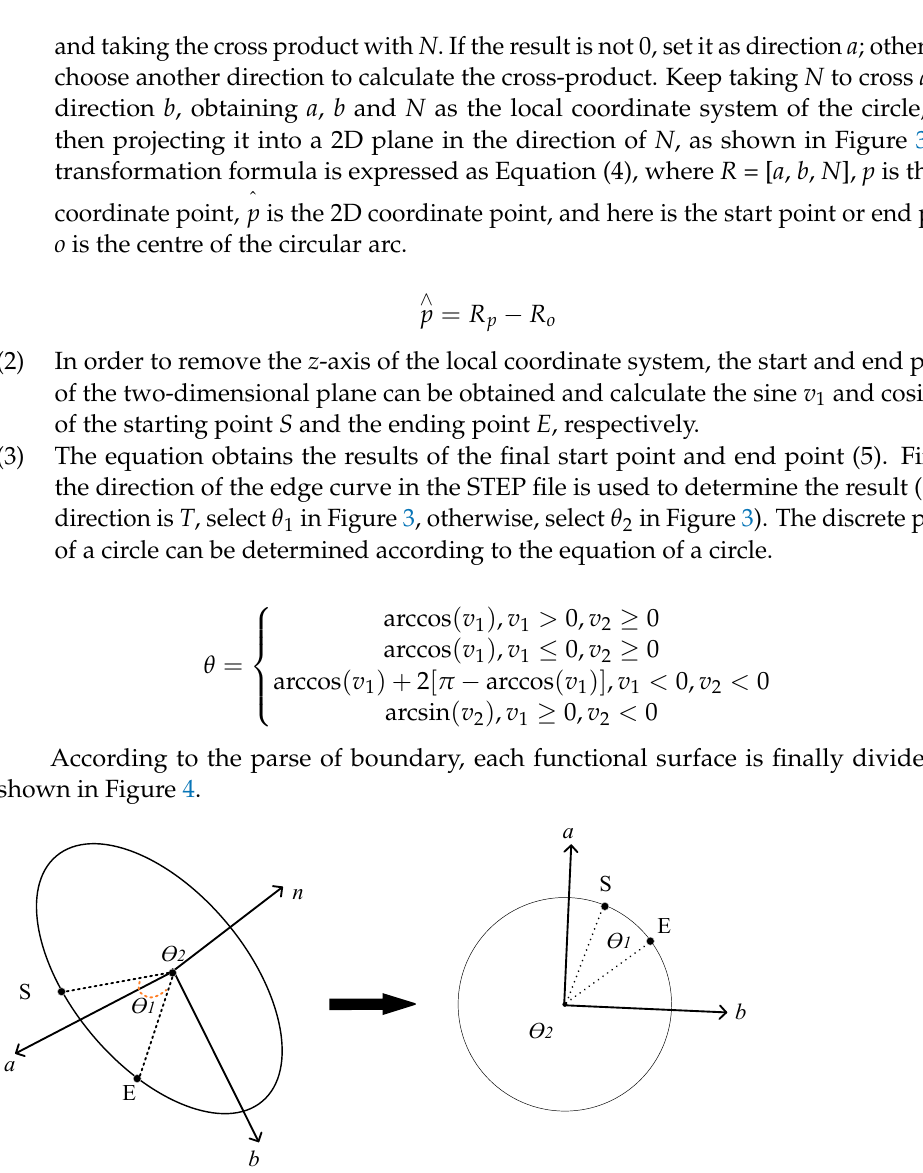
Figure 3. The definition of angle in a circular arc.